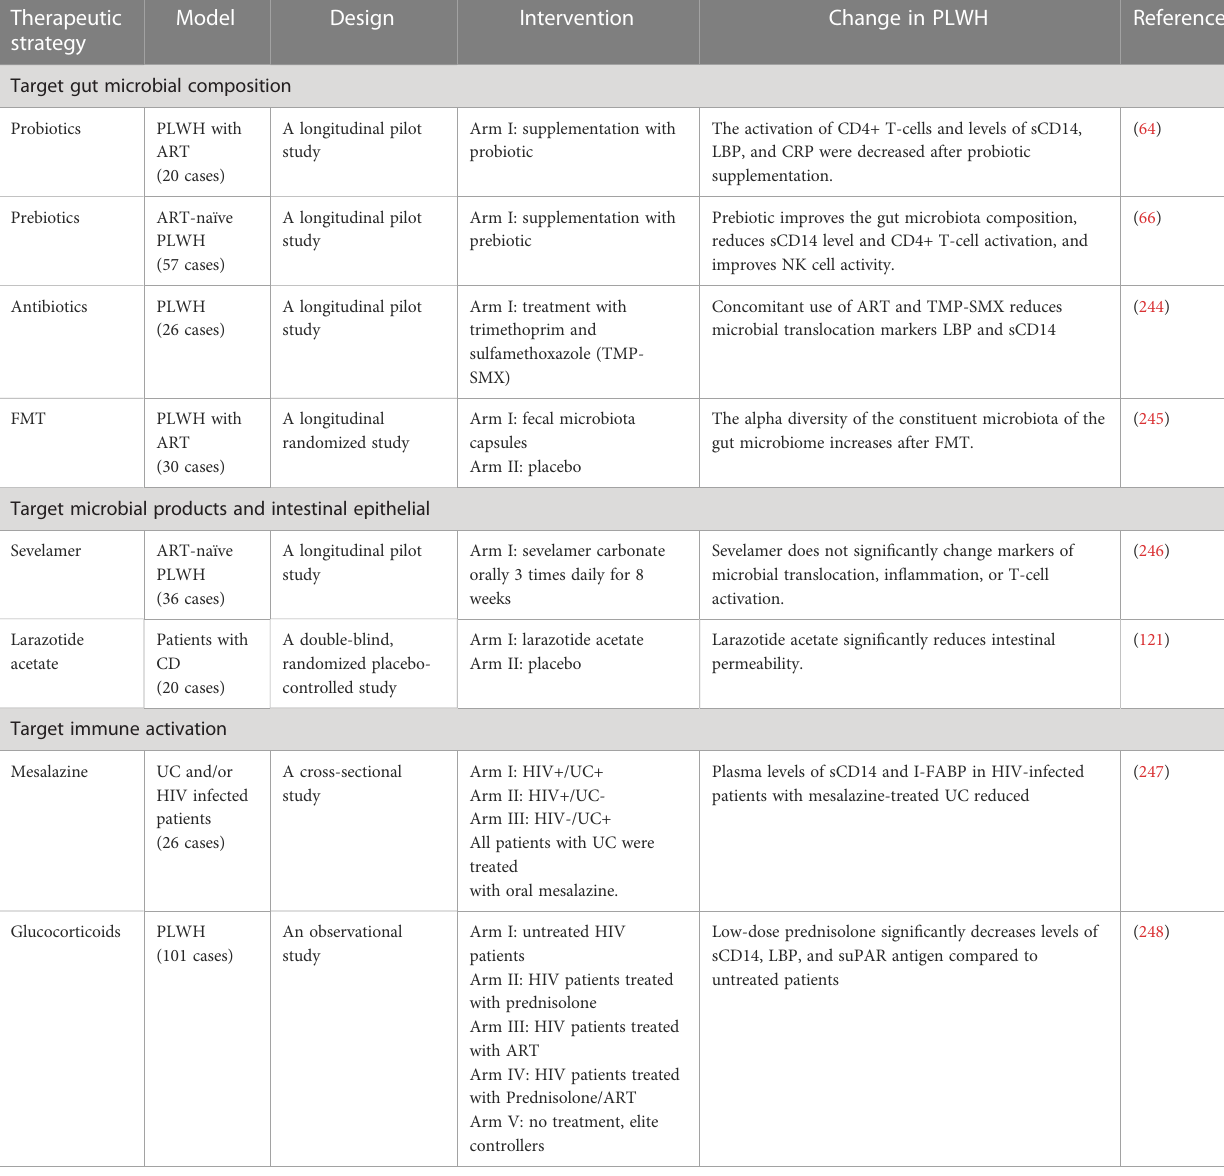
TABLE 2 Potential therapeutic strategies to improve the integrity of the intestinal